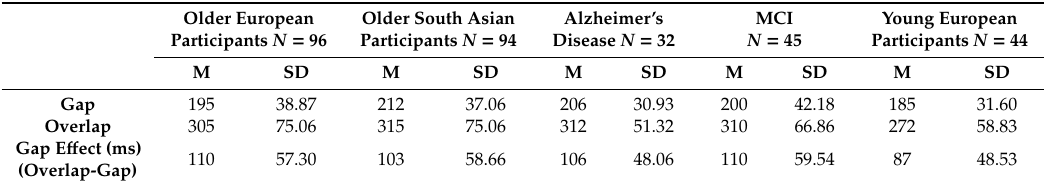
Table 3. Table displaying mean reaction times and standard deviations for the prosaccade task gap and overlap